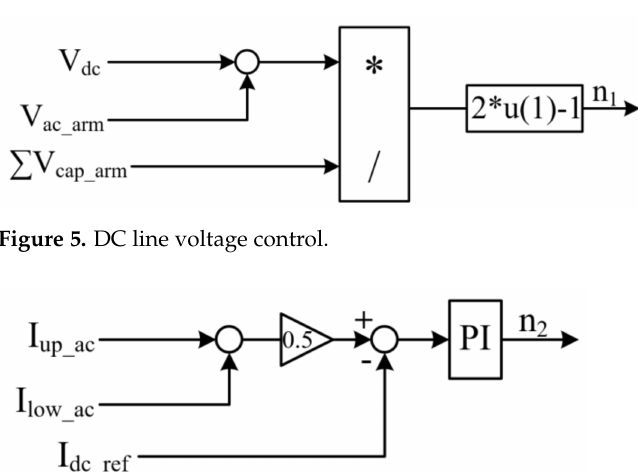
Figure 4. SM capacitor voltage control.